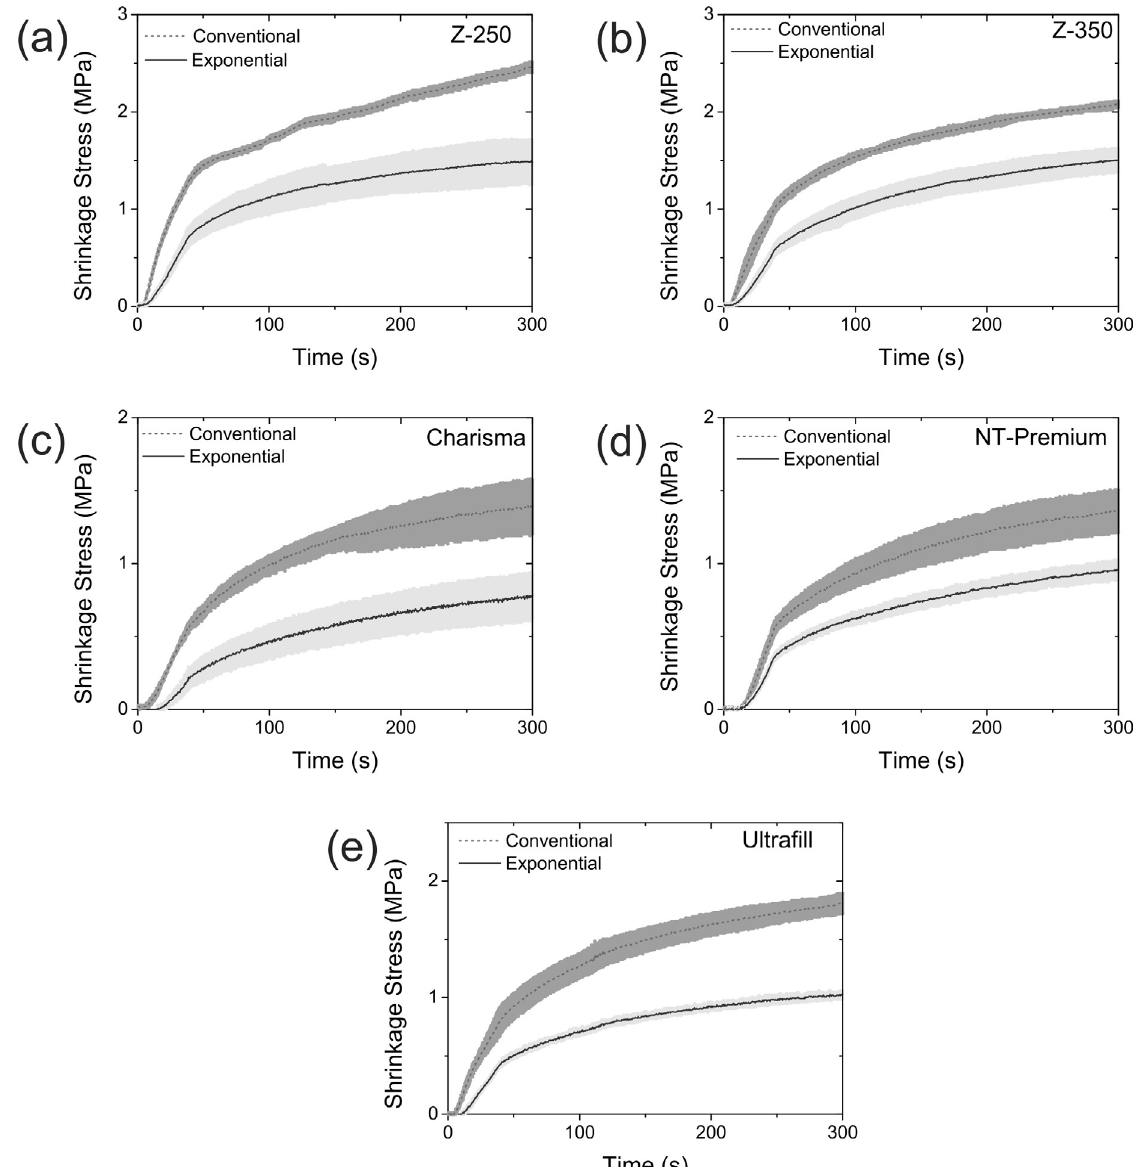
Figure 2- Comparison of the shrinkage stress between the conventional and exponential methods for composite resins: (a) Z-250; (b) Z-350; (c) Charisma; (d) NT Premium and (e)